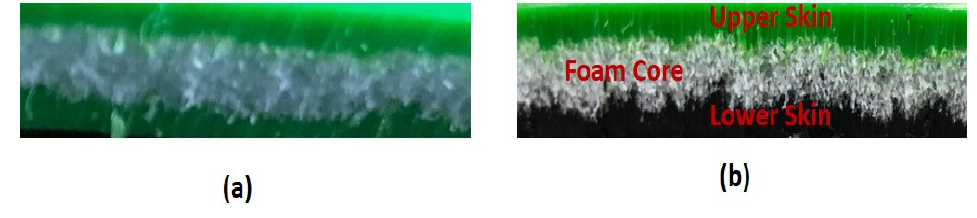
Figure 1. Rotationally moulded ( a ) non-reprocessed and ( b ) reprocessed sandwich structures.